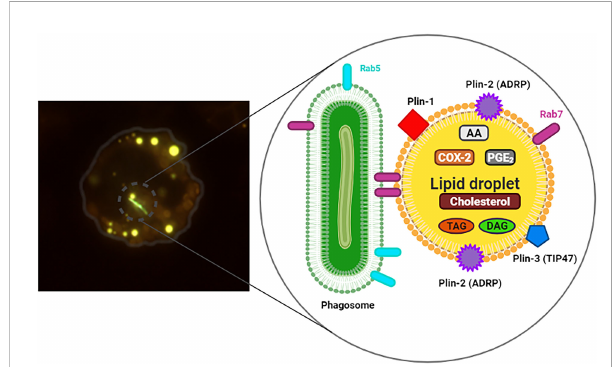
FIGURE 1 Infected macrophage exhibiting Lipid droplets (LDs). On the left, murine macrophage showing internalized mycobacteria ( M. bovis BCG) stained with Live/Dead Baclight Bacterial ® Viability Kit (green) and many cytoplasmic LDs stained with Bodipy ® 493/503 (yellow). In the detail, representation of the structure and composition of LD in association with phagosome containing bacteria (green), Rab5 and Rab7. Triacylglycerol (TAG), diacylglycerol (DAG),